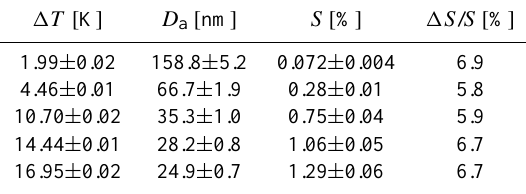
Table 1. Characteristic parameters from the 5 calibration experi- ments performed during the campaign (arithmetic mean ± standard deviation). The last column shows the maximum relative deviation of individual calibration data points from the average calibration line ( S vs. 1T ), indicating maximum relative uncertainties in S